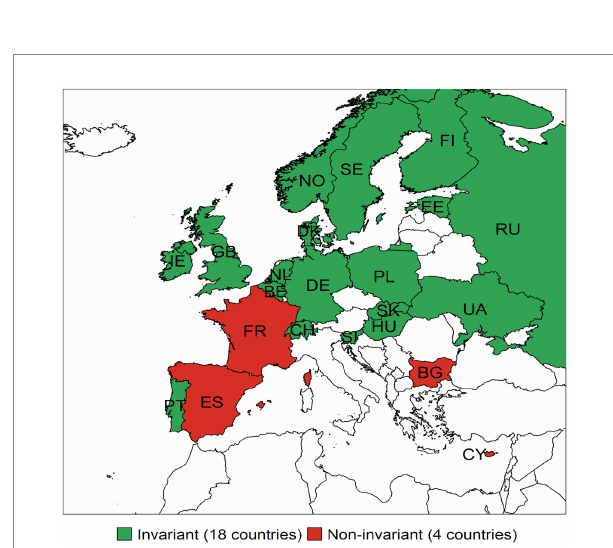
FIGURE 2 Countries with full intercept invariance in negative affect across time (Round 3–Round 6). The figure displays the countries where the full scalar invariant model holds across time points for those countries present at both ESS Rounds. The countries where NA was not fully invariant across time were Cyprus, Bulgaria, France, and